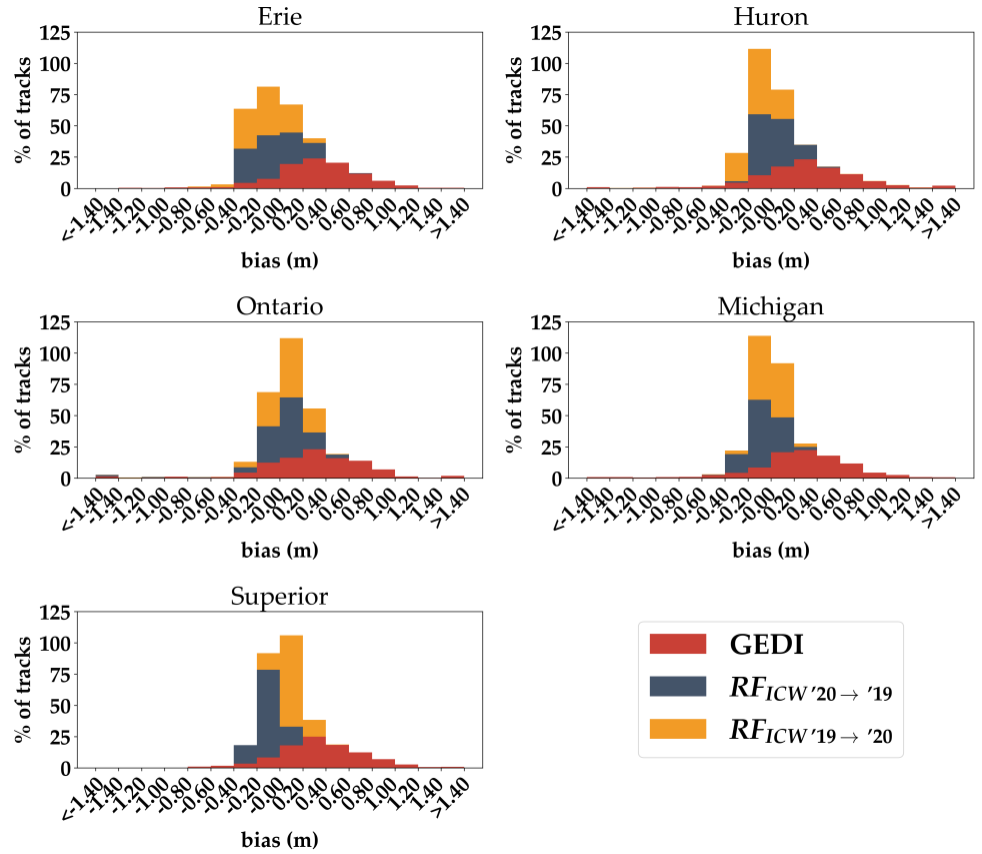
Figure 8. Stacked histograms of the distribution of the mean difference (bias) between GEDI (resp. 𝑅𝐹 𝑅𝐹 𝐼𝐶𝑊 ′19→′20 and 𝐼𝐶𝑊 ′20→′19 ) and in situ elevations across the five studied lakes. Biases corre- spond to the mean difference calculated for GEDI shots grouped by acquisition date and the ing beam. 𝑅𝐹 𝐼𝐶𝑊 ′19→′20 (resp. 𝑅𝐹 𝐼𝐶𝑊 ′20→′19 ) corresponds to the 𝑅𝐹 𝐼𝐶𝑊 model, trained over 2019